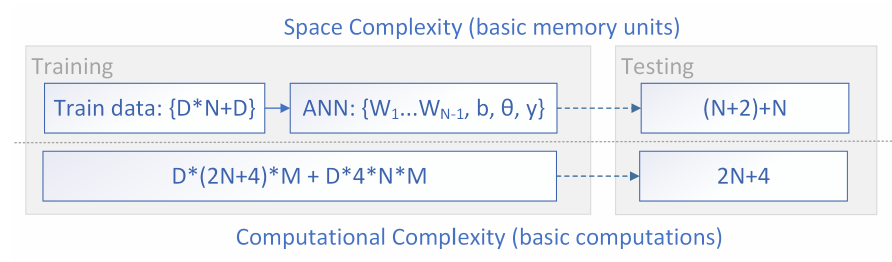
Figure 3. Example of space and computational complexity of single-layer